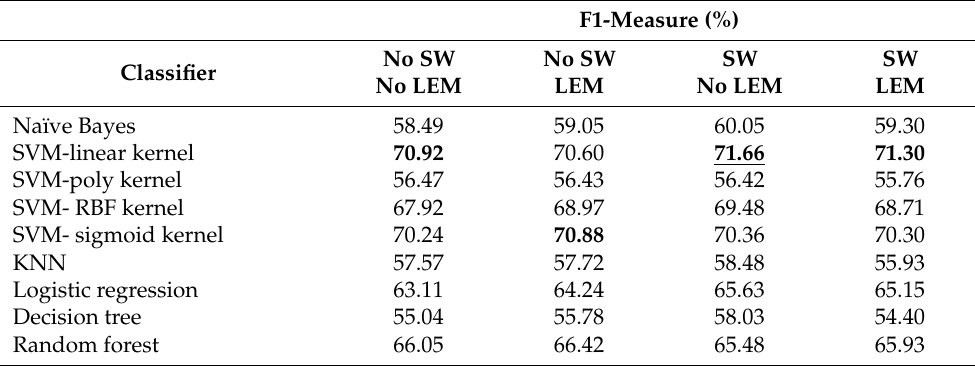
Table 8. Effect of bilingual preprocessing using stop-word removal (SW) and lemmatizing (LEM) for the case